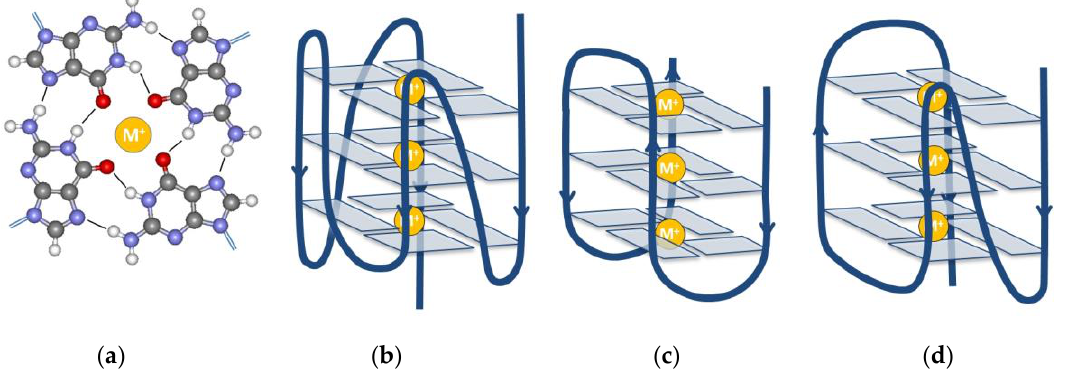
Figure 1. The main building block and the most frequently observed G-quadruplex structures. ( a ) Structure of a G-quartet with the metal ion (M + ) in the middle of the plane. ( b ) Parallel; ( c ) antipar- allel; ( d ) and hybrid structures.